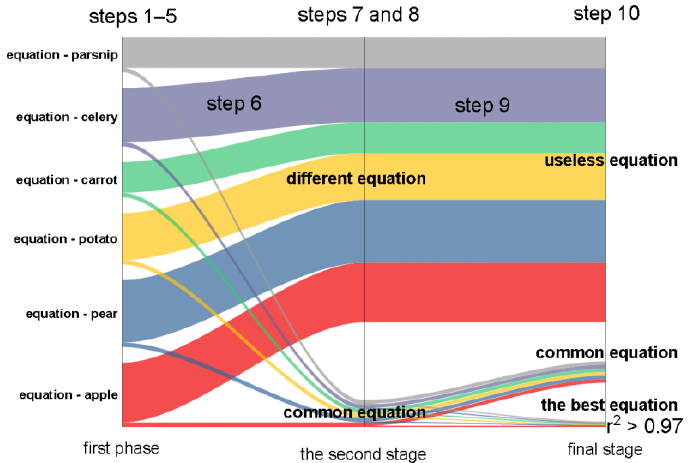
Figure 17. Working steps for choosing the common mathematical equation.